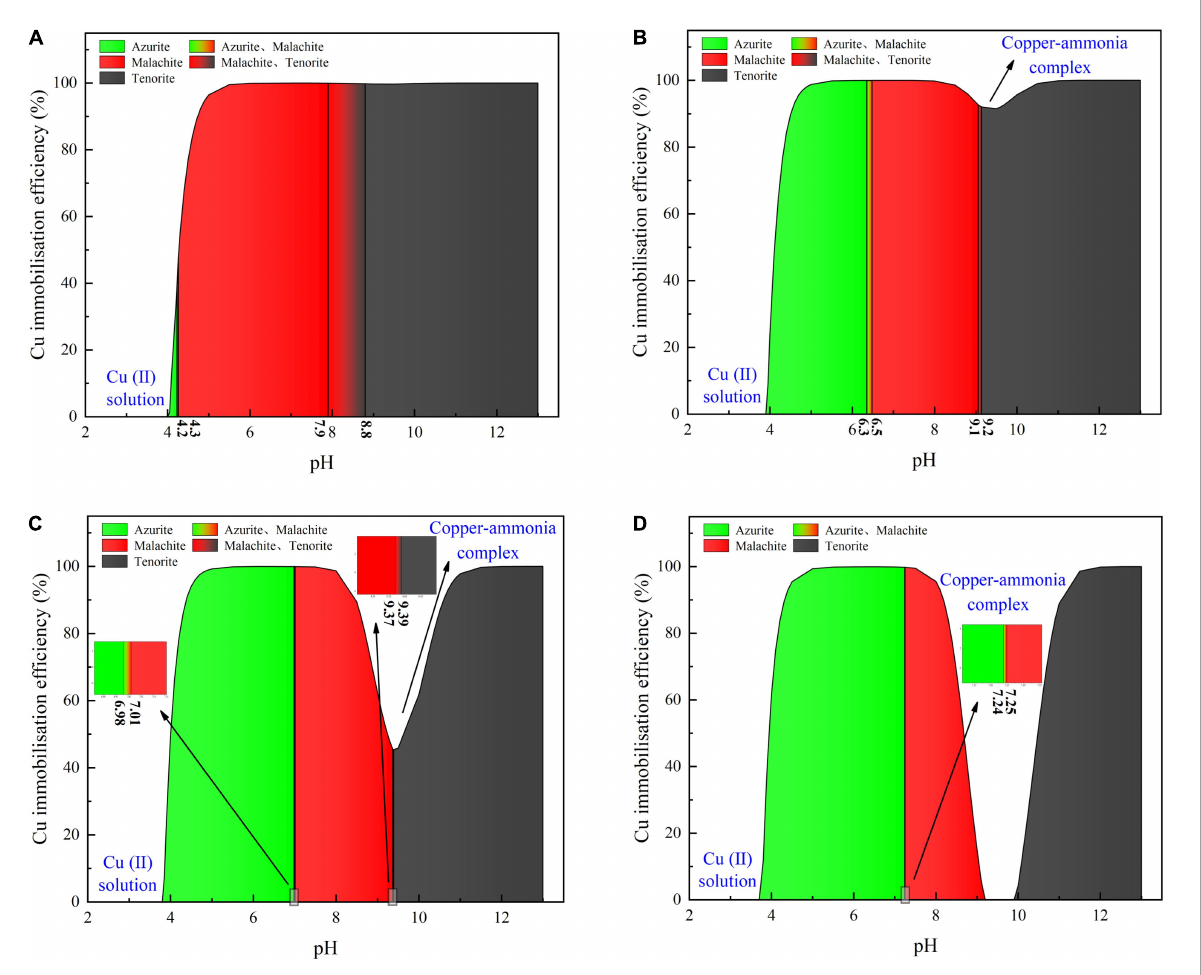
FIGURE8 (A) copper immobilization efficiency vs. pH relationship for the inoculation proportion = 1:9, (B) copper immobilization efficiency vs. pH relationship for the inoculation proportion = 1:3, (C) copper immobilization efficiency vs. pH relationship for the inoculation proportion = 1:1, and (D) copper immobilization efficiency vs. pH relationship for the inoculation proportion = 3:1 [Cu(NO 3 ) 2 concentration = 60